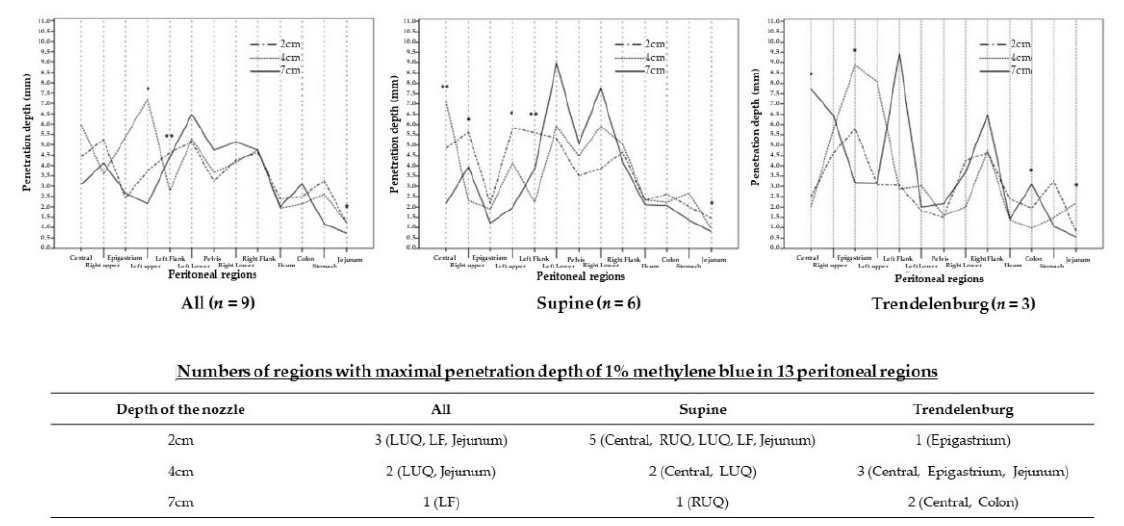
Figure 3. Number of regions with the maximal penetration depth of 1% methylene blue in 13 regions of pigs’ abdomen based on the depth of the nozzle.